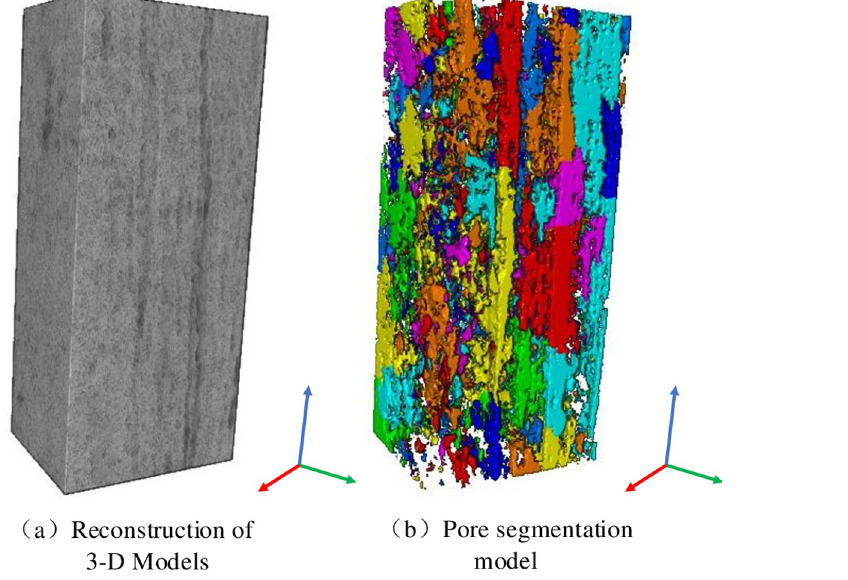
Fig 5. Comprehensive characterization of the pore-fracture